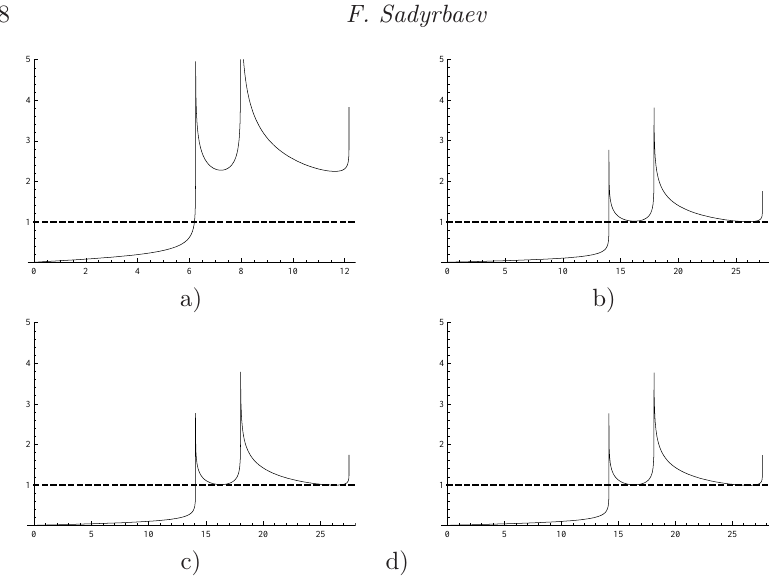
Figure 10. The graphs of the time map U ( α,λ ) : a) λ = 0 . 1 , 1 solution, b) λ = 0 . 50264 , 2 solutions, c) λ = 0 . 51 , 3 solutions, d) λ = 0 . 51586 , 4 solutions.